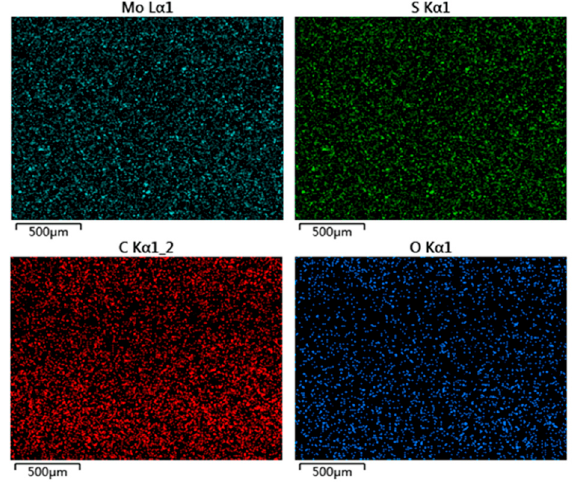
Figure 4. Elemental distribution maps for the surface of EP+6%MoS 2 +6%H-CNTs.